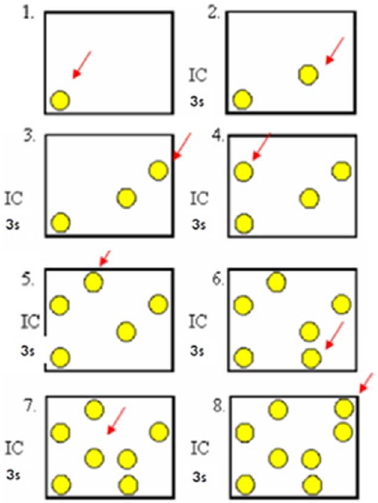
Figure 1. Experimental design for the Spatial Delayed Recog- nition Span Task. The full procedure included 40 trials of up to a maximum of 8 identical stimuli, 10 trials for each stimulus category (geometric pictures, positive, neutral and negative faces). The participant had to identify the stimulus in the new location. There was a 3-second interval of configuration (IC) between each new stimulus is presented on the touch screen.